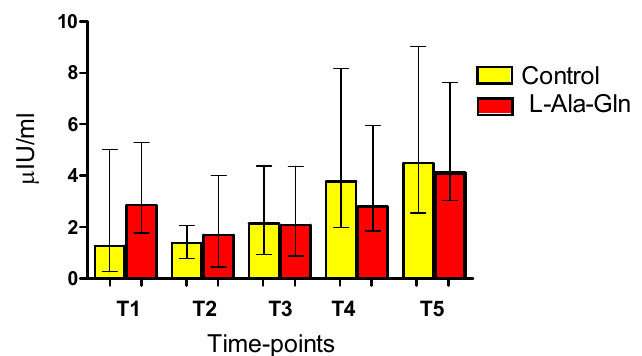
FIGURE 2 - Insulin concentrations (µIU/ml) in the plasma of saline (control) and L-Ala-Gln-treated patients. Bars represent median with interquartile range of control (yellow bars) and L-Ala-Gln (red bars) groups during different time-points. Groups studied are not significantly different by ANOVA test